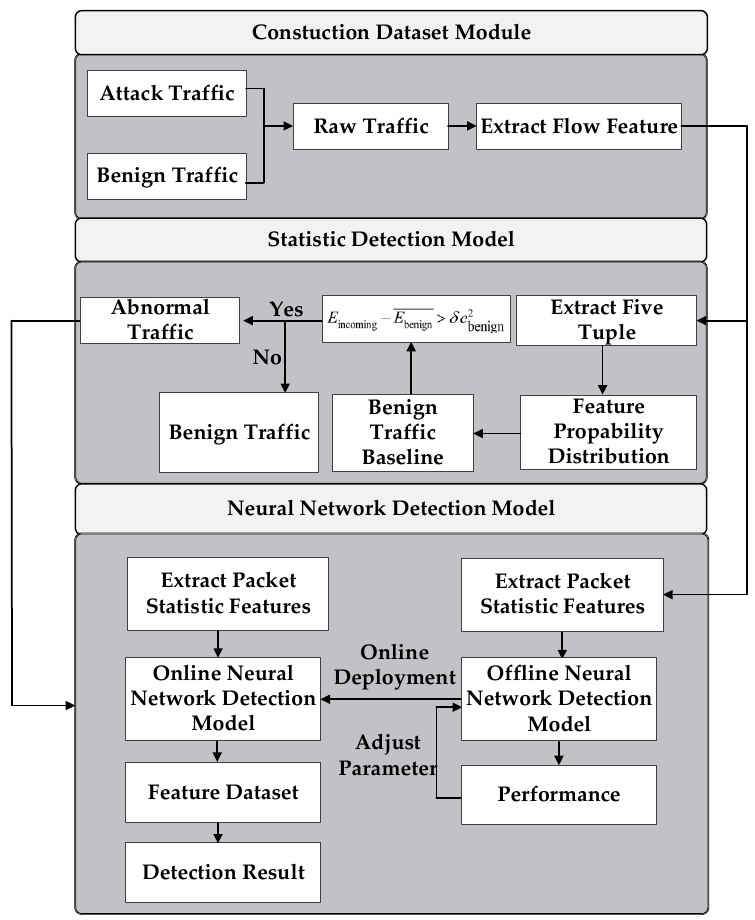
Figure 1. Two-stage DDoS detection model.